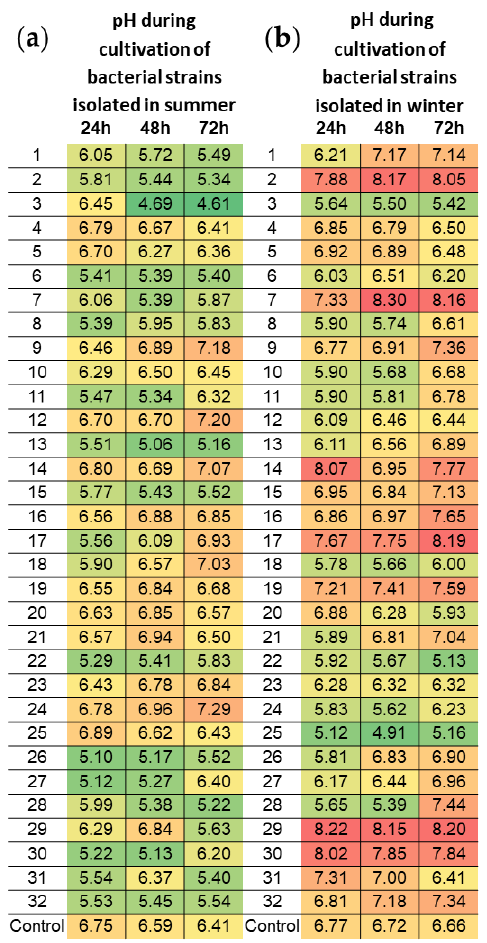
Figure 10. Acidifying activity of the selected bacteria strains (1–32) isolated in summer ( a ) and winter ( b ) seasons from biofilm surfaces located on the Northern Pergola. Heat maps present the pH after 24, 48 and 72 h of different bacterial isolates incubation in Blickfeldt liquid medium. The data represent averages of three independent experiments.